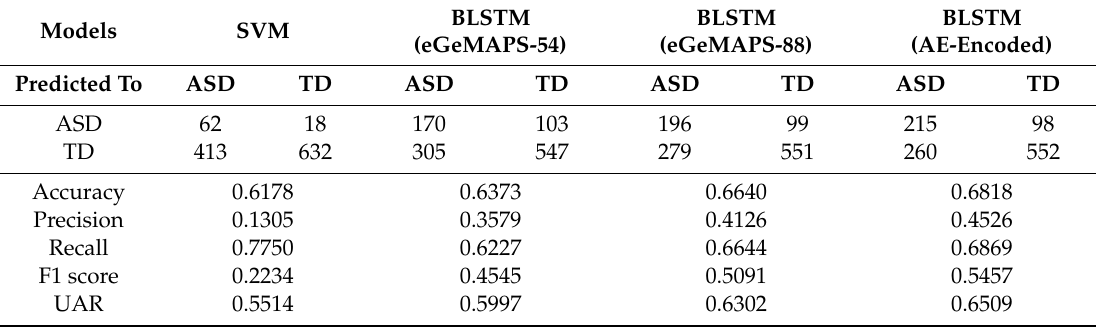
Table 4. Classification results from the support vector machine (SVM), BLSTM with 88 or 54 eGeMAPS features, 54 selected eGeMAPS features, and BLSTM with AE-encoded